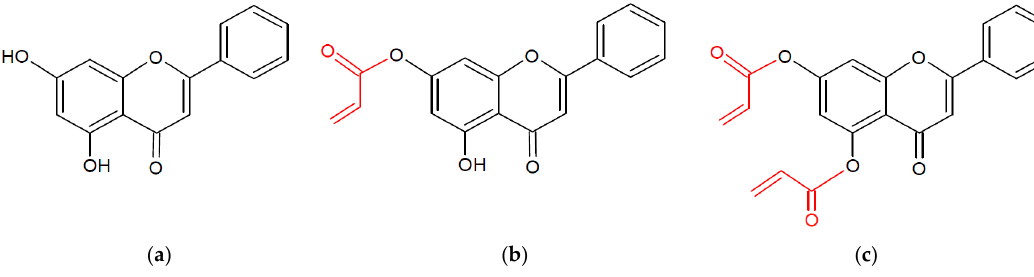
Figure 2. Chemical structure of ( a ) Chrysin; ( b ) Chrysin-monoacrylate; ( c ) Chrysin-diacrylate.